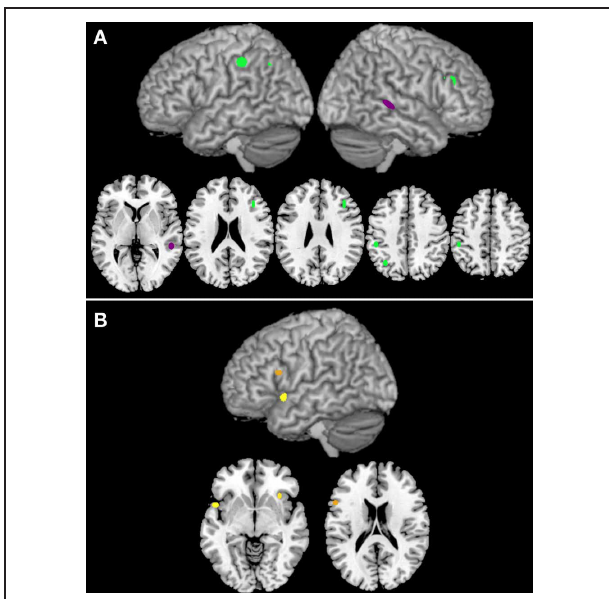
FIGURE 3 | Panel (A) illustrates the clusters that are associated either with noun (green) or verb (purple) processing. Panel (B) reports the clusters that are associated with task-by-grammatical class interaction (the brighter the color, the higher the number of activation peaks included in the cluster).